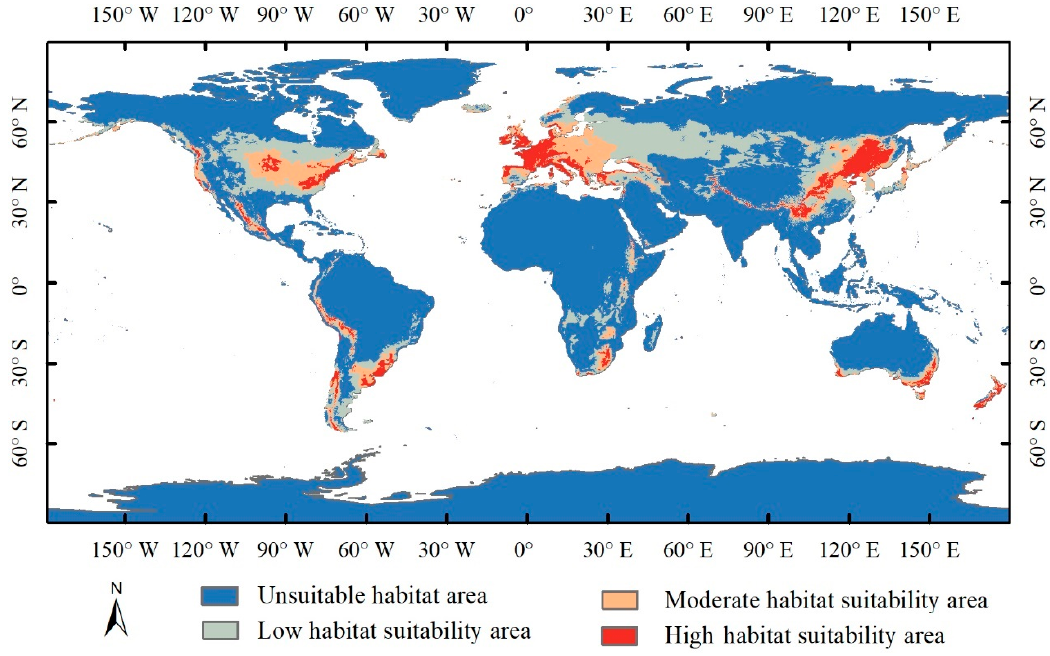
Figure 4. The predicted range of currently suitable areas for S. noctilio under historical climatic